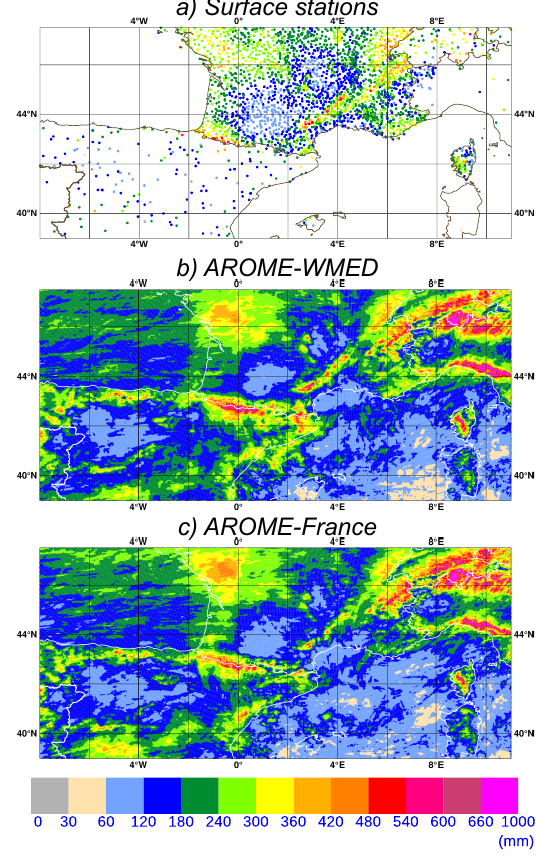
Figure 13. Accumulated precipitation (mm) during SOP1 period ranging from 05 September to 05 November 2012 measured by surface stations. Accumulation between 06:00 and 06:00UTC the next day, (a) predicted by AROME-WMED (b) and by AROME- France (c)